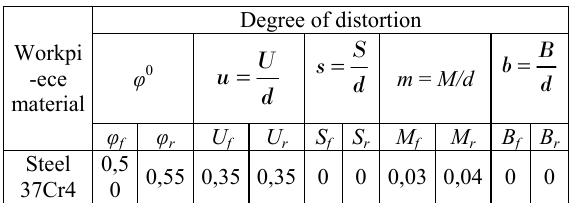
Table 1. Parameters of geometric accuracy of cut workpieces